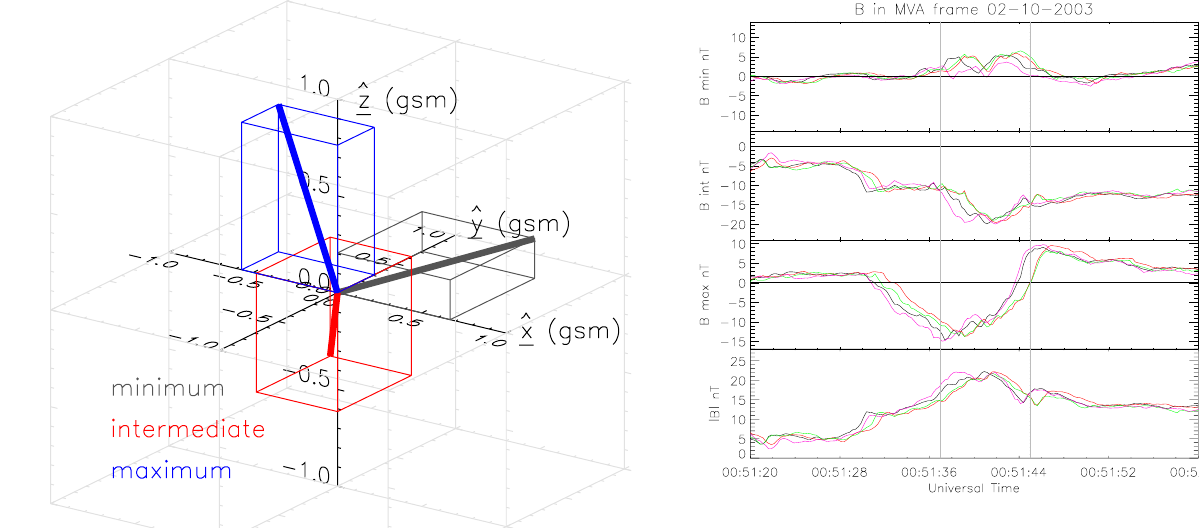
Fig. 5. Magnetic field observations from 2 October event trans- formed into the variance frame of Cluster 1; the magnetic field in the minimum, intermediate and maximum variance directions (Fig. 4) and the magnitude from all spacecraft. Cluster colours are in the same format as those in Fig. 3. The approximate boundaries of the flux ropes, located at the inflection points, are marked by grey